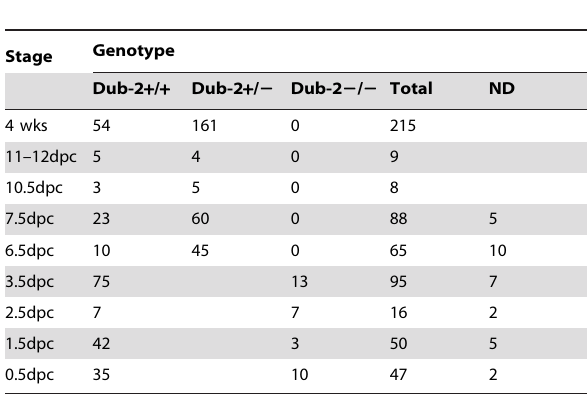
Table 1. Genotyping analysis for different stages of